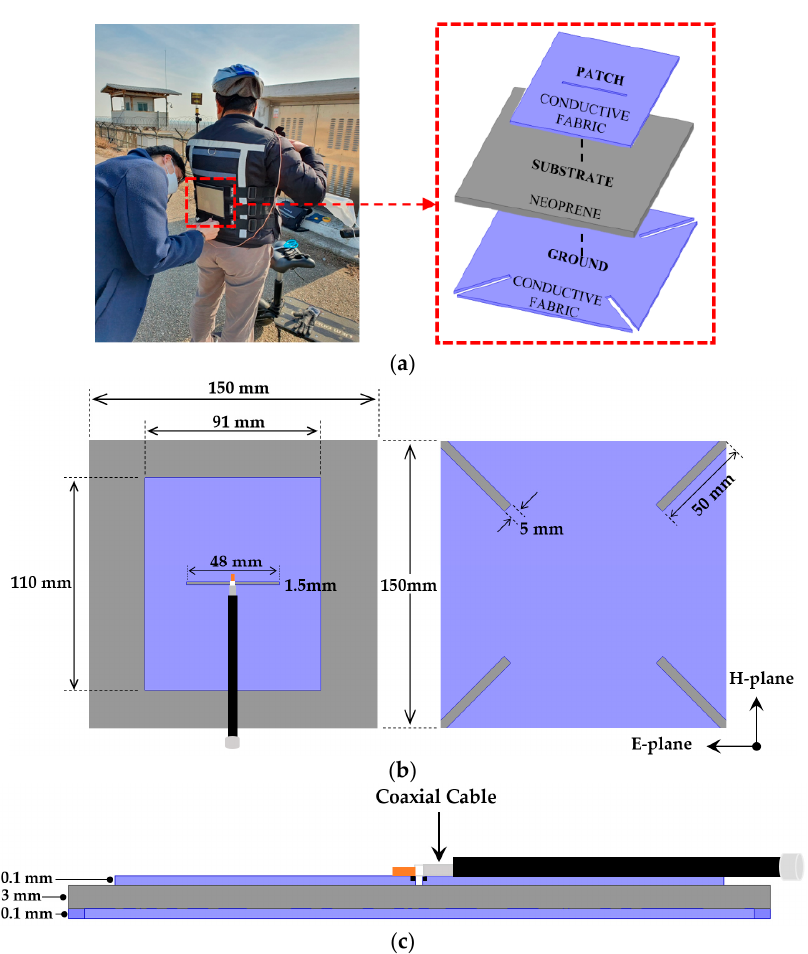
Figure 1. Geometry of proposed wearable antenna with cable placement ( a ) left: textile antenna embed on vest/right: perspective view; ( b ) top and bottom view; ( c ) side view. embed on vest/right: perspective view; ( b ) top and bottom view; ( c ) side